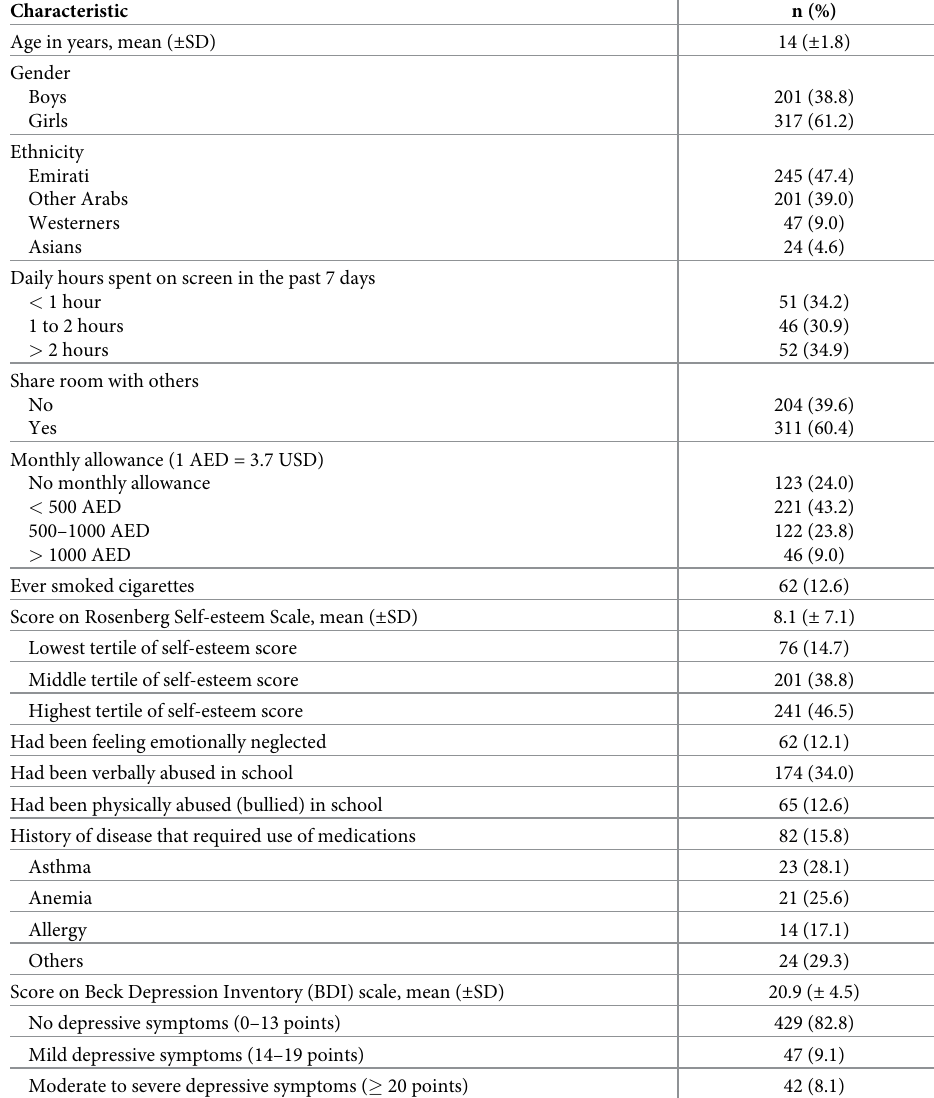
Table 1. Characteristics of adolescents 12 to 18 years of age (n = 518)in Al Ain, United Arab Emirates. Characteristic n